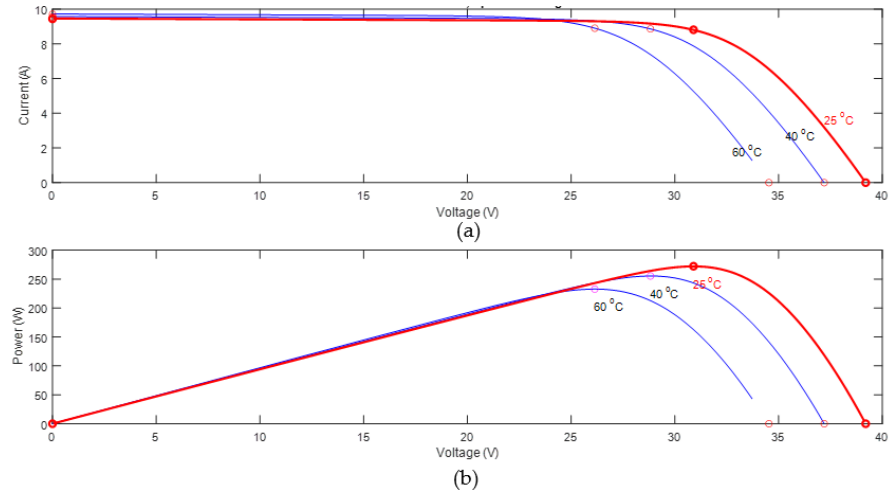
Figure 1. ( a ) I-V and ( b ) P-V characteristics of a solar module under varying temperature [21,22].